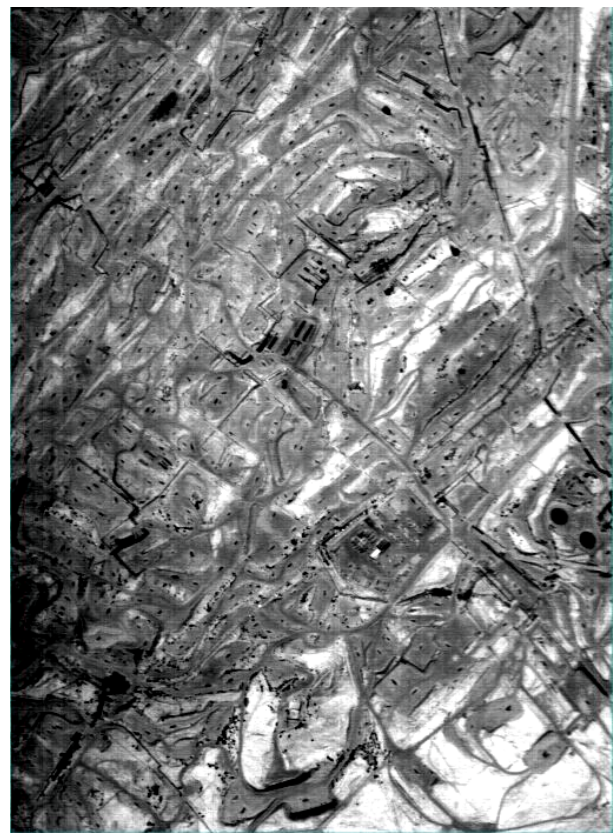
Figure 4. Single-band view of HyTES image subset from 8 July 2014. This subset was used to produce the simulated data